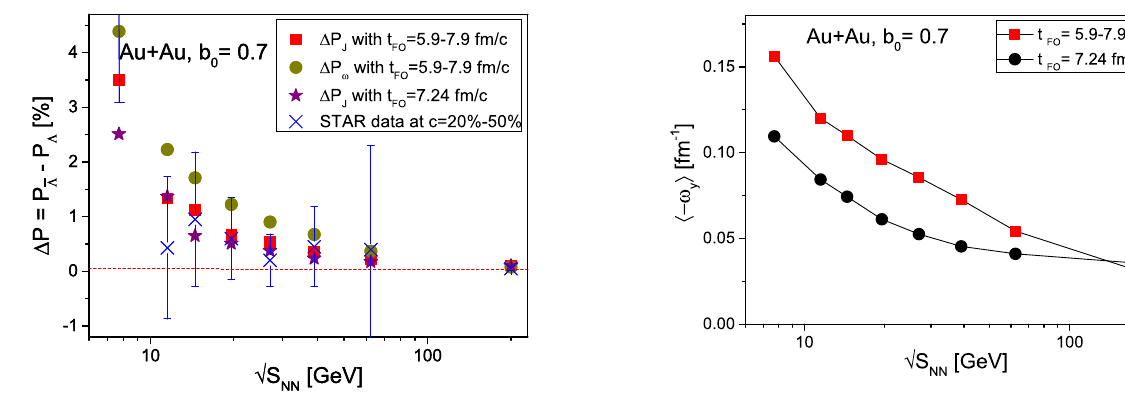
Fig. 4 The polarization splitting between Λ s and ¯ Λ s for Au+Au col- √ s NN = 7.7–200 GeV with impact parameter ratio b 0 = 0 . 7. lisions at The red squares represent the polarization splitting Δ P J in Eq. (15), with varied freeze-out time t FO = 7 . 24 fm/c. The green circles corre- spond to polarization splitting P ω which is induced by vorticity only. As comparison, Δ P J with fixed t FO = 7 . 24 fm/c are shown by purple stars. The experimental data denoted by cross symbols with error bars are extracted from Ref. [17], as an average for centralities c = 20–50%, corresponding to impact parameter ratio b 0 = 0.45–0.7 [27]